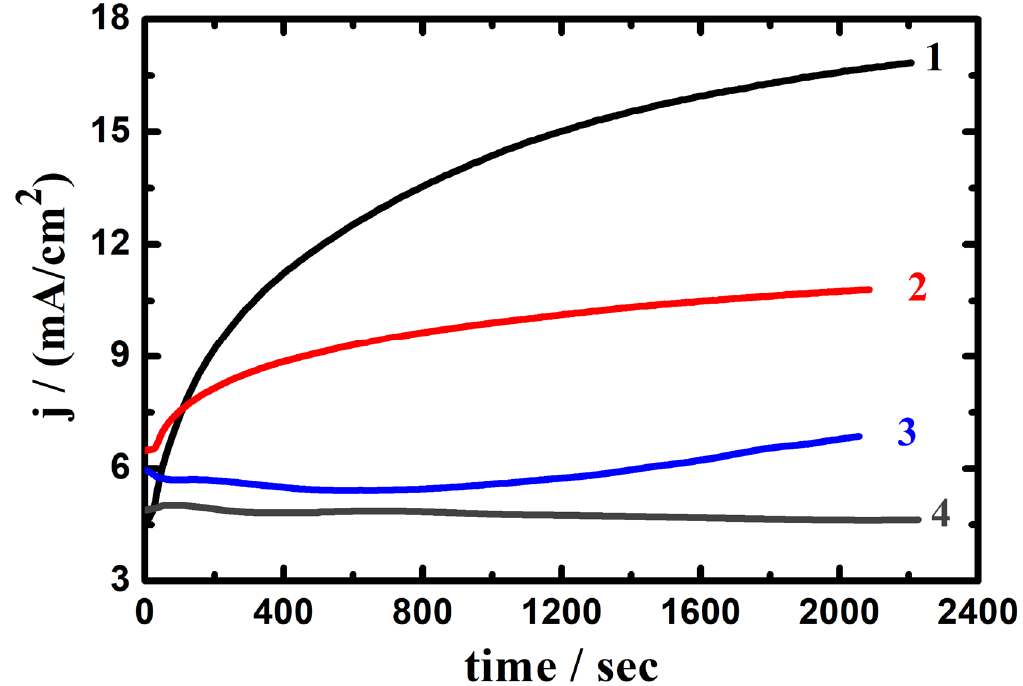
Figure 15 . Current curves collected at −50 mV (Ag/AgCl) for (1) CrFeCuMnNi; (2) CrFeCuMnNi-3 vol.% Al 2 O 3 ; (3) CrFeCuMnNi-3 vol.% Y 2 O 3 ; and (4) CrFeCuMnNi-3 vol.% TiO 2 after their immersion in 3.5% NaCl solutions for 60 min.